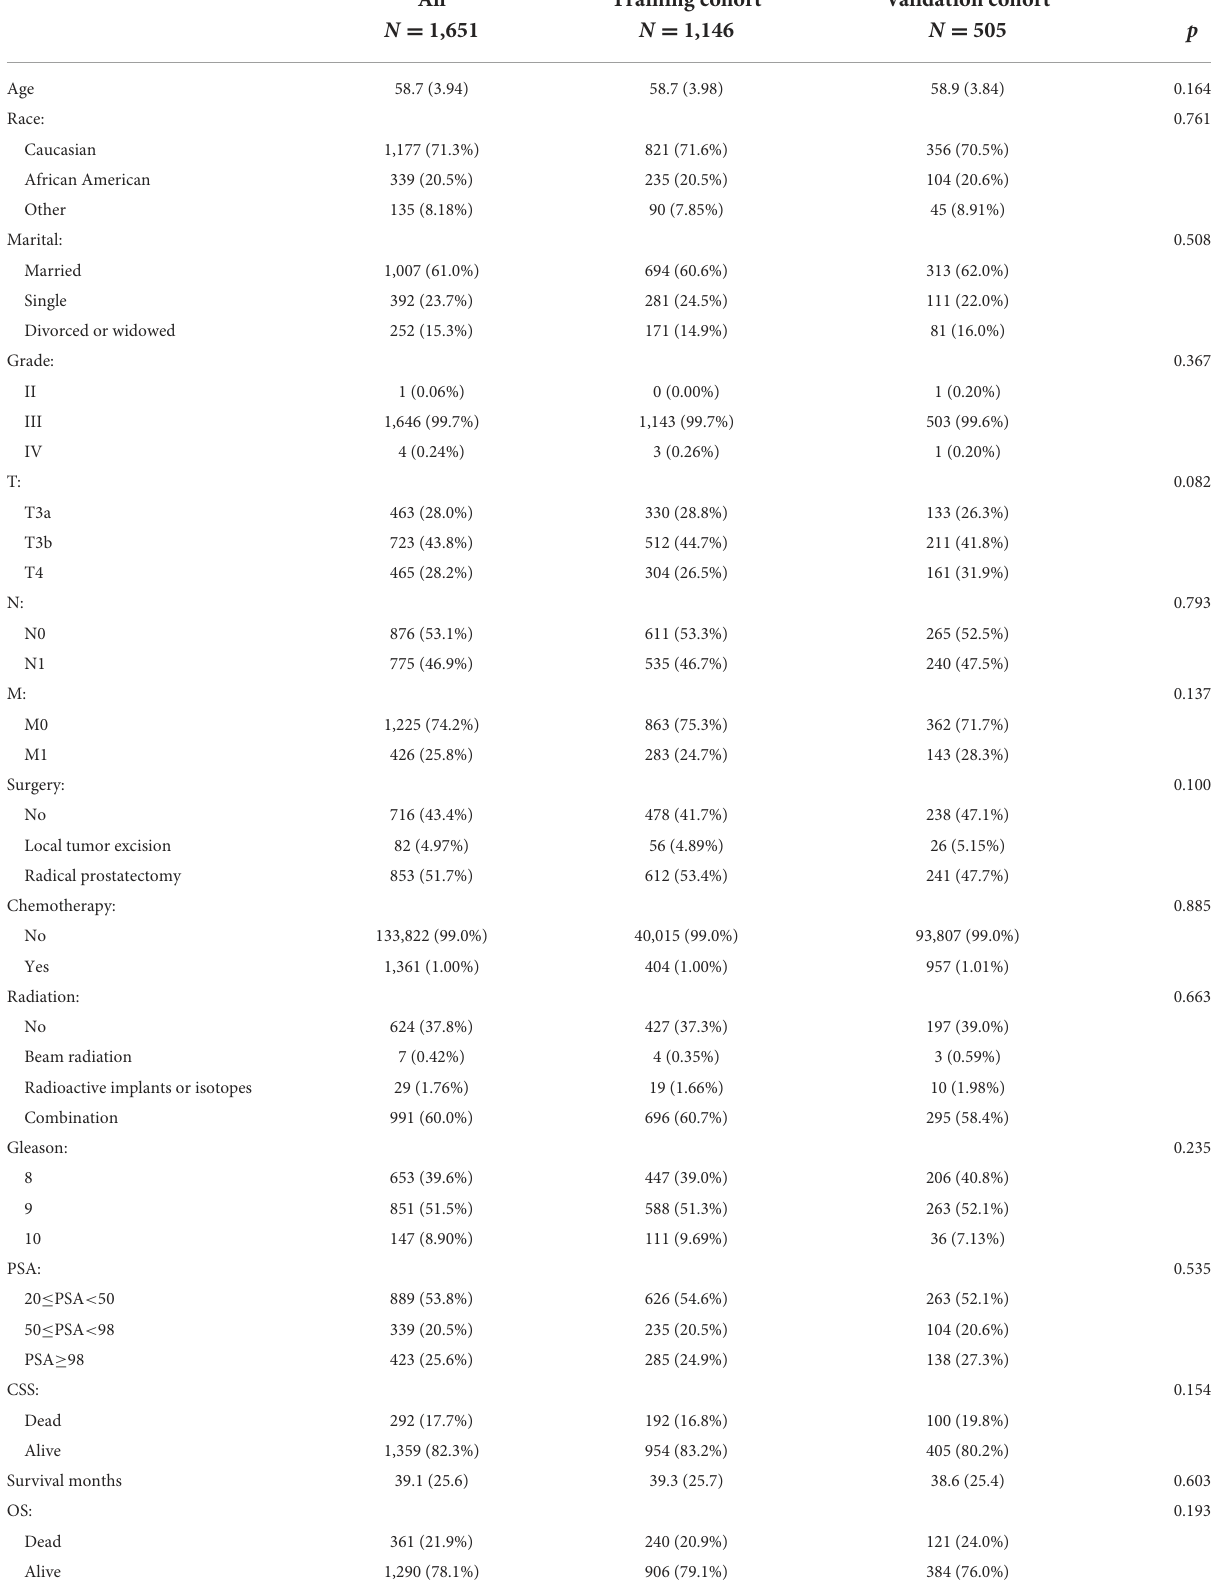
TABLE 1 Clinicopathological characteristics of patients with high-risk PC in middle age.